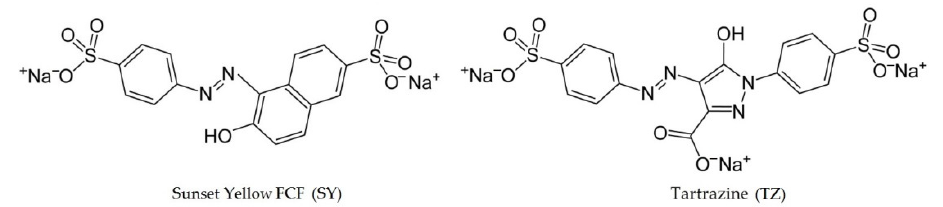
Figure 1. Structural formulas of SY and TZ.